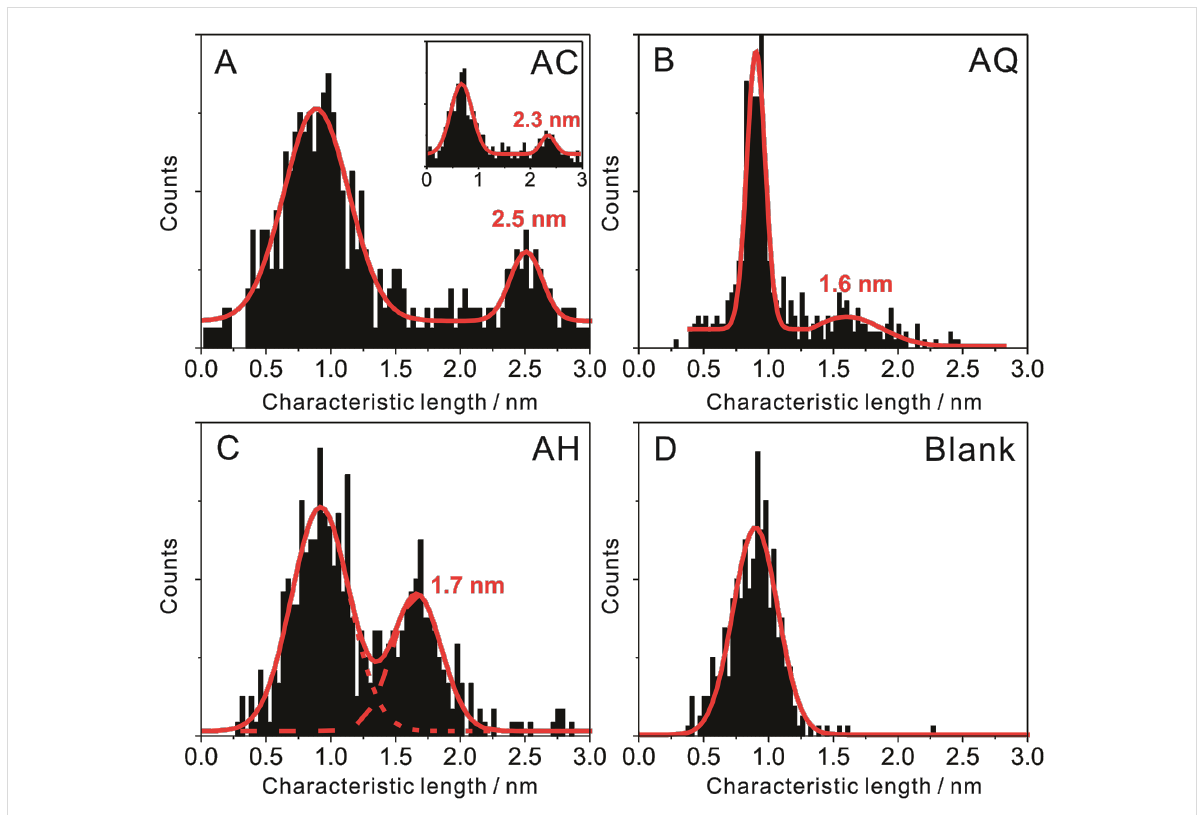
Figure 9: Plateau-length distributions (black) and Gaussian fits (red) of (A) AC (B) AQ (C) AH and (D) the blank control system, as constructed from the data shown in Figure 8. The conductance range selected for the plateau length analysis ranges between 0.1 G 0 and 10 − 8 G 0 . The inset in panel (A) represents the plateau length analysis of AC in a limited conductance range from 0.1 G 0 to 10 − 6 G 0 in order to extract the length of the main conductance plateau.